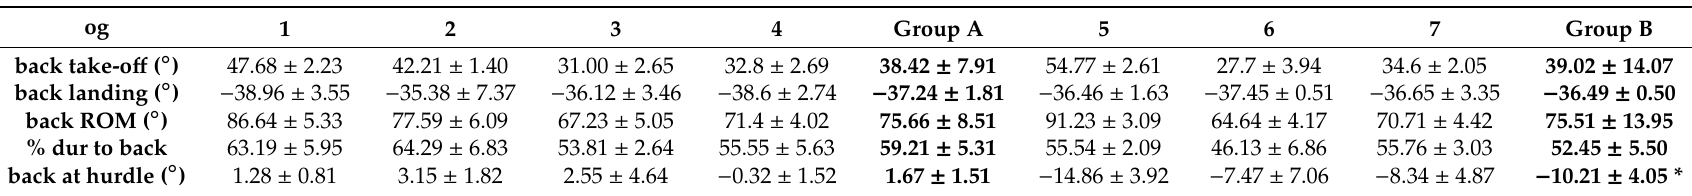
height at hurdle (m) max height-h. at h.(m) Table 3. Results (mean ± standard deviation) of back inclination angle of seven agility dogs jumping over a 60-cm hurdle. In bold results of Group A, dogs ranked as excellent jumpers and competing in the greater level (level 3) and of Group B, dogs ranked as less-skilled jumpers and of a lower level in the competition (level 2). *, significant di ff erences by a Mann–Whitney U test ( p < 0.05). og back take-o ff ( ◦